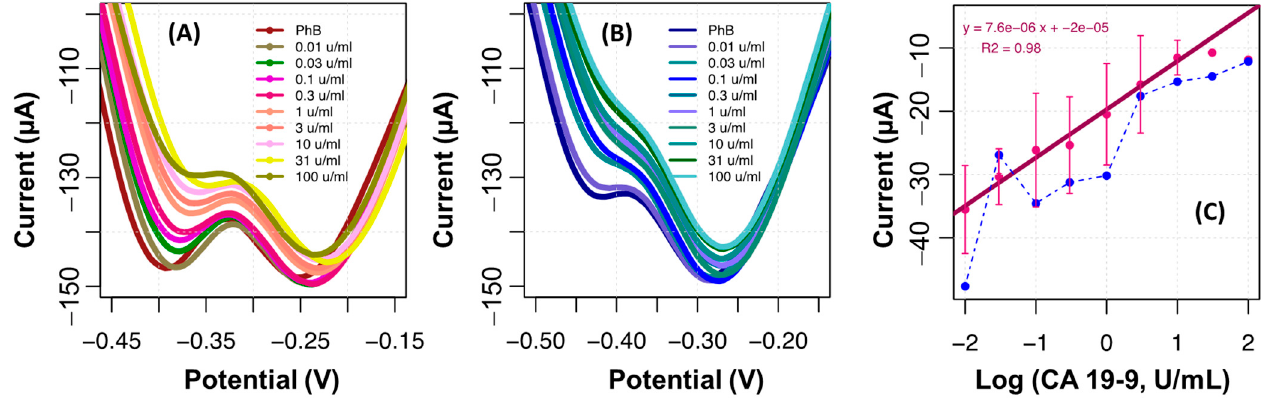
Figure 6. DPV voltammograms of MIP ( A ) and NIP ( B ) films assembled on C-SPE and incubated consecutively with increasing concentrations of CA 19-9 standard solutions, from 0.10 to 100 U/mL, along with the corresponding average calibration plots ( C ) plotting MIP as dark-pink, and NIP as light-blue.